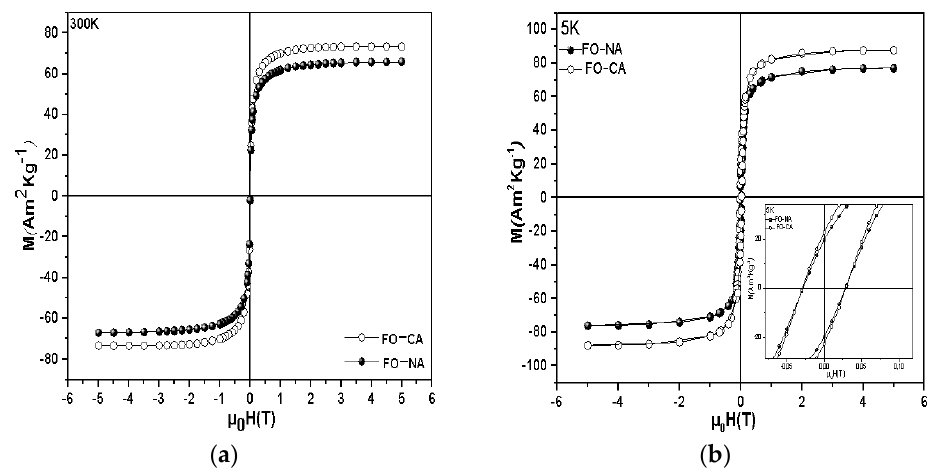
Figure 6. Hysteresis loops recorded at ( a ) 300 K and at ( b ) at 5 K, Inset ( b ): details around zero field .